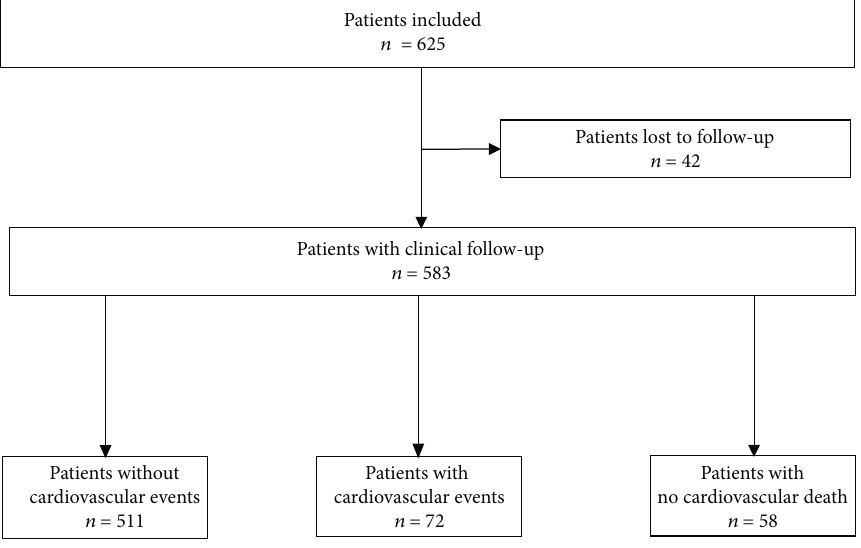
Figure 2: Study fl ow